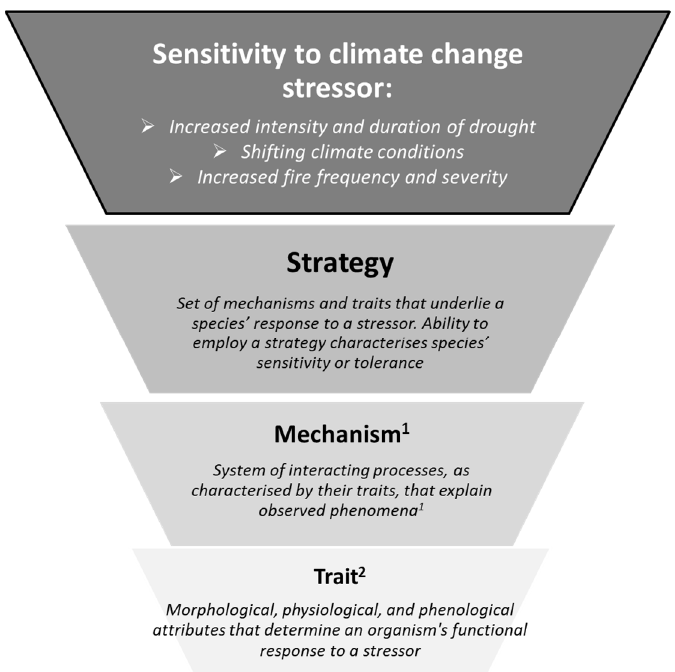
Figure 1. Conceptual synthesis of the relationship between traits and tree functional response to the three studied climate change stressors. The hierarchy employed here is adapted from [13]. Superscript numbers indicate source of definitions 1 [24], 2 [25].